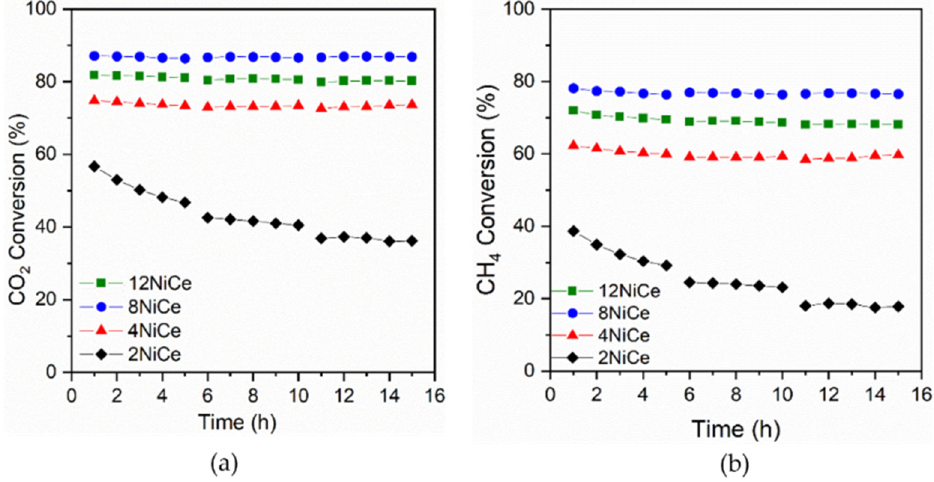
Figure 9. Time on stream (TOS) experiments: ( a ) CO 2 conversion and ( b ) CH 4 conversion as a function of time on stream. Experimental conditions: CO 2 :CH 4 :N 2 :He = 20:20:20:140 vol.%; flow = 200 cm 3 min − 1 ; GHSV = 300 L g − 1 h − 1 ; T = 800 °C.